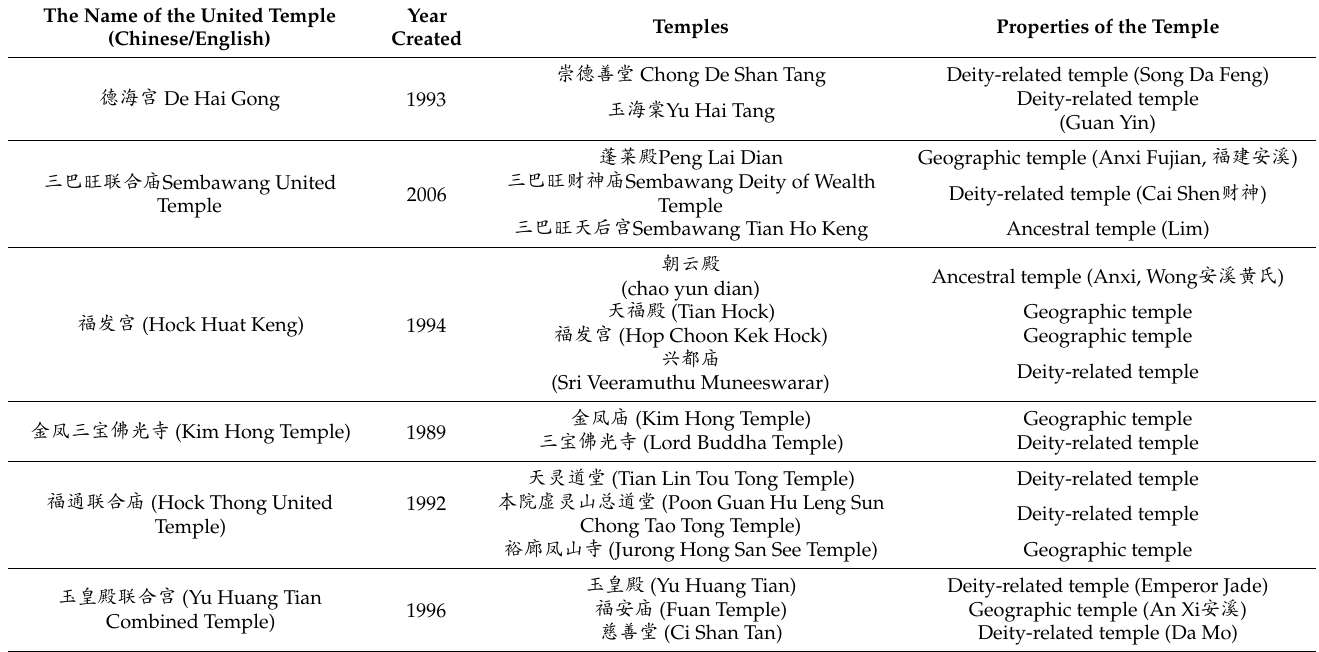
Table 10. Existing deity-related temples in